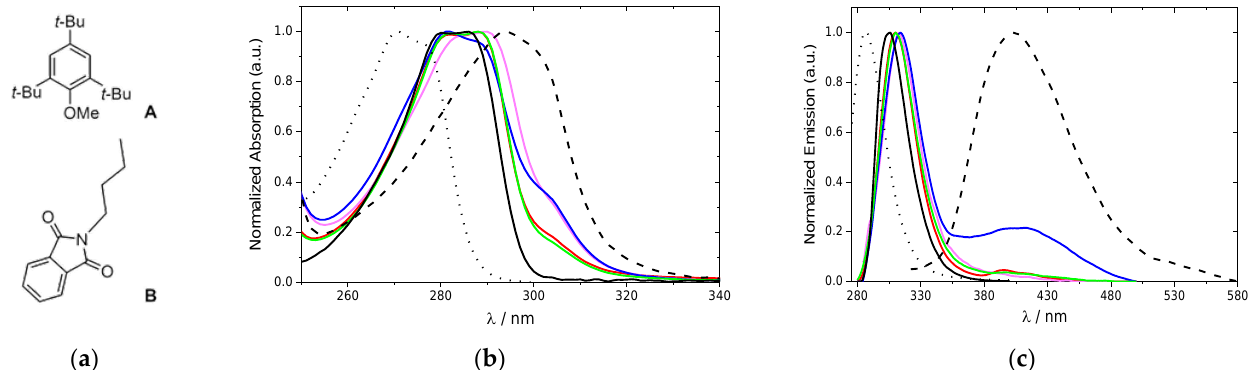
Figure 8. ( a ) Chemical structures of the model compounds A and B . Normalized absorption ( b ) and emission ( c ) spectra of 1 (black line), A (dotted line), B (dashed line), 2a (red line), 3a (pink line), 3b (blue line) and 5a (green line) in CH 2 Cl 2 .